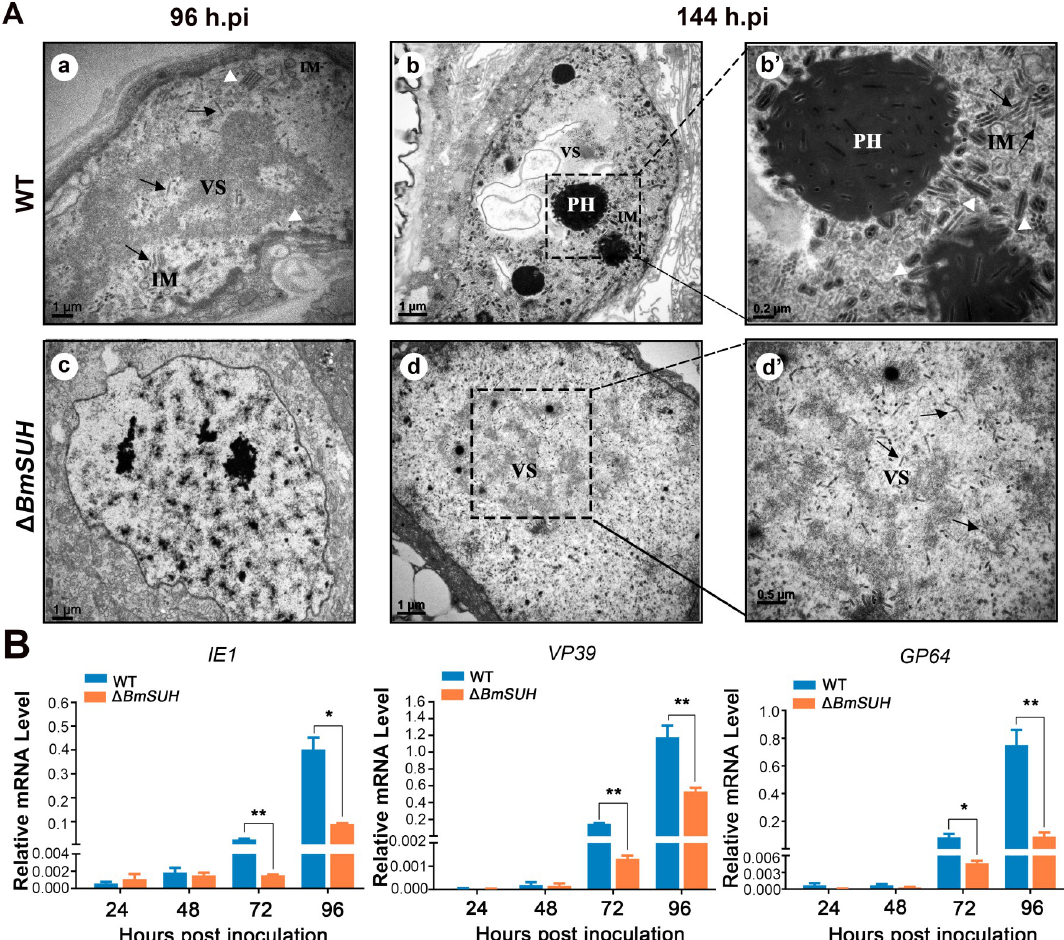
Fig 4. Interruption of BmSUH reduced the production of virions and viral gene expression. (A) TEM observations of virions in Δ BmSUH and WT larval midgut column epithelial cells. Electron-dense virogenic stroma (VS) and progeny nucleocapsids (black arrows) were observed both in the midgut of WT and Δ BmSUH larvae. The white triangles show intranuclear microvesicles (IM) and nucleocapsids associated with the membranous vesicular structures. PH, polyhedral. (B) Expression levels of different-phase viral genes, IE1 , GP64 , and VP39 in WT or Δ BmSUH larvae midgut after inoculated orally with 10 6 OBs (mean ± SEM). � p < 0.05 and �� p < 0.01 by two-tailed Student t test.